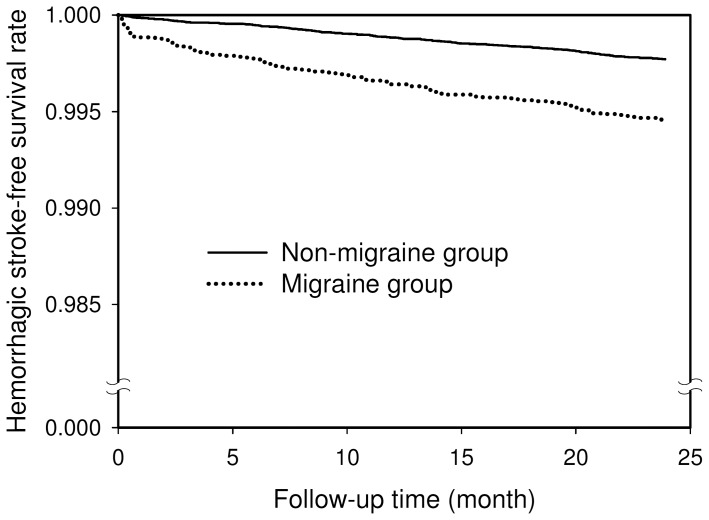
Hemorrhagic stroke-free survival rates for the migraine group (dotted line) and the non-migraine group (solid line).